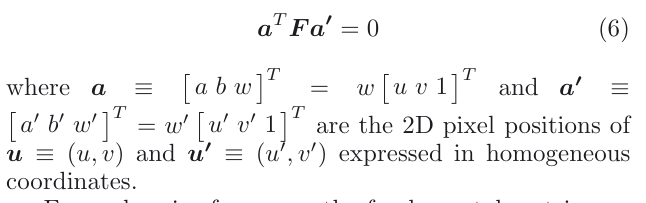
Fig. 4. Epipolar geometry principles. x C camera centres, x ≡ ( x, y,z ) is the 3D point. u ≡ ( u, v ) and u (cid:2) ≡ ( u (cid:2) , v (cid:2) ) represent the 2D projection of x onto the image planes of the first and second camera respectively. e and e (cid:2) are the epipoles of the two cameras, i.e. the intersection of the line joining the two camera centres with the image plane. (cid:2) is the epipolar line corresponding to point u ≡ ( u, v